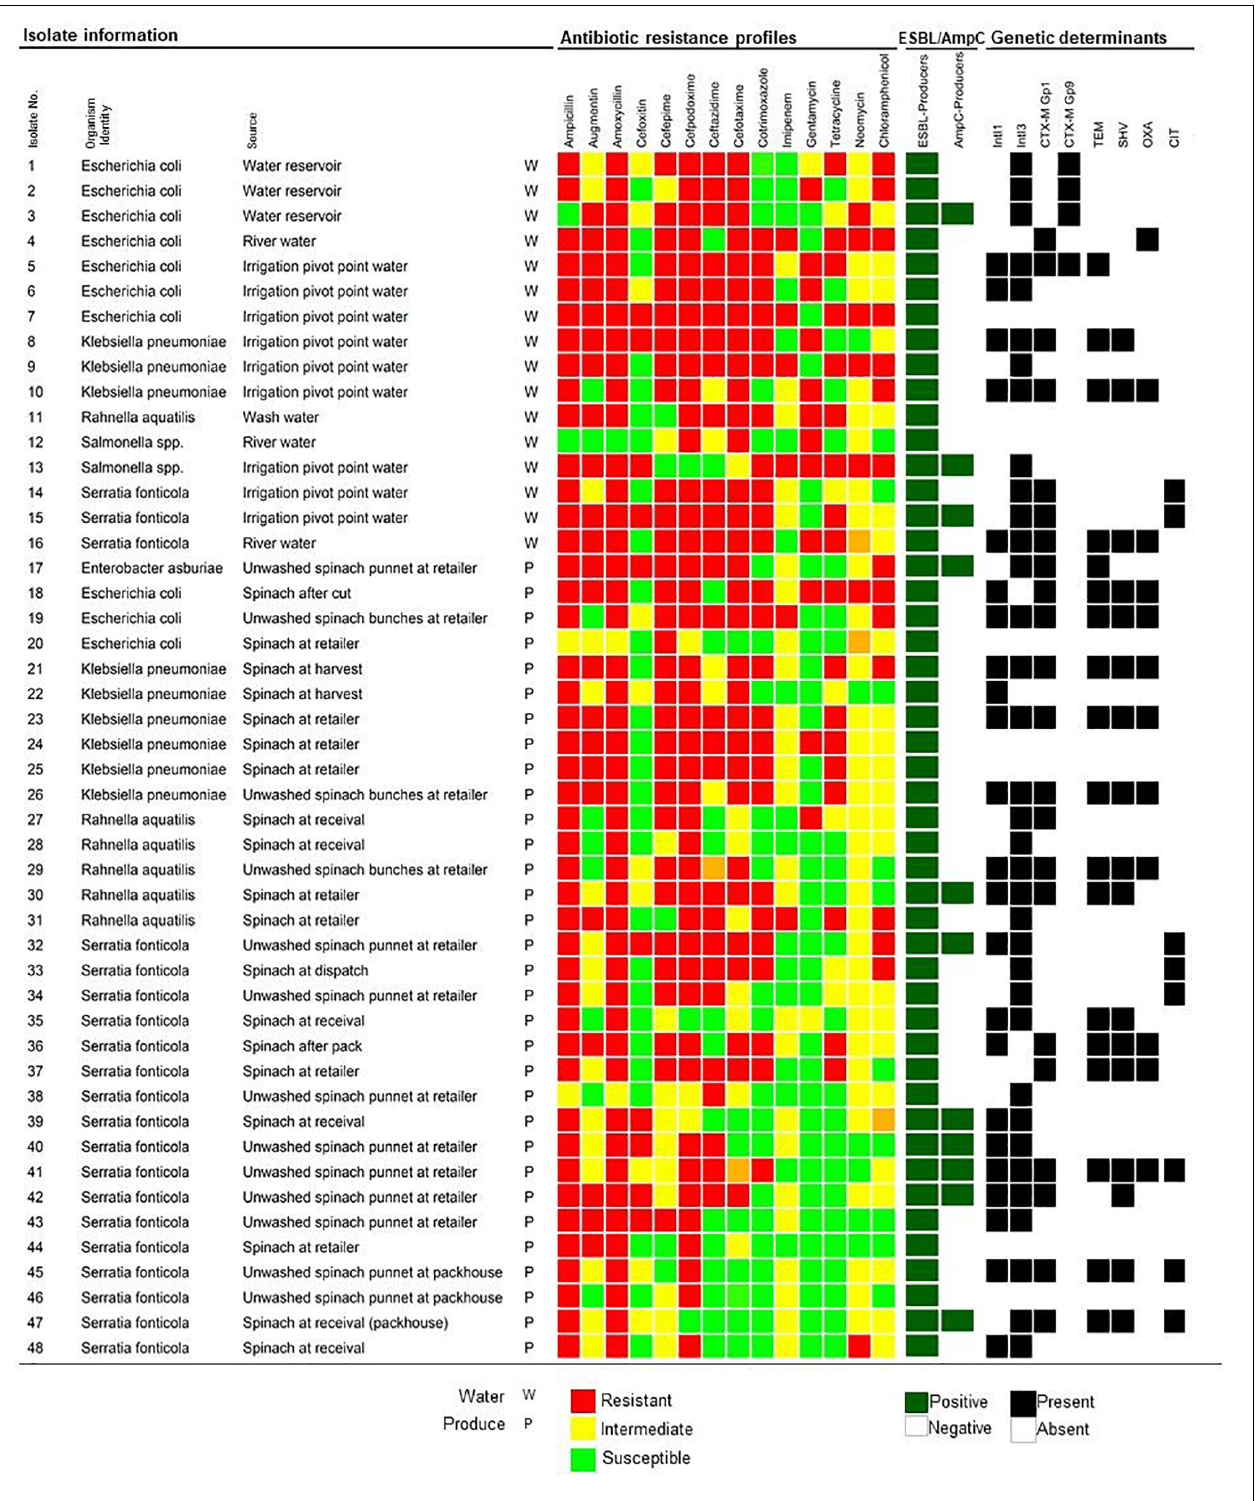
FIGURE 1 | Extended-Spectrum- and AmpC- β -Lactamase producing Enterobacteriaceae isolated from water, spinach, and contact surface sources, indicating the phenotypic antibiotic resistance profiles and the detection of ESBL and/or AmpC, and integron genetic determinants. The color code of the antimicrobial resistance profiles indicate the resistant, intermediate resistant, or susceptible phenotypes to specific antibiotics from seven different classes. ESBL/AmpC production is indicated as positive or negative and detection of genetic determinants indicated as present or absent.